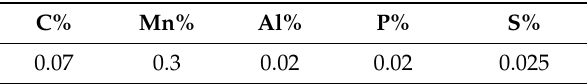
Table 1. Chemical composition of DC04 steel.